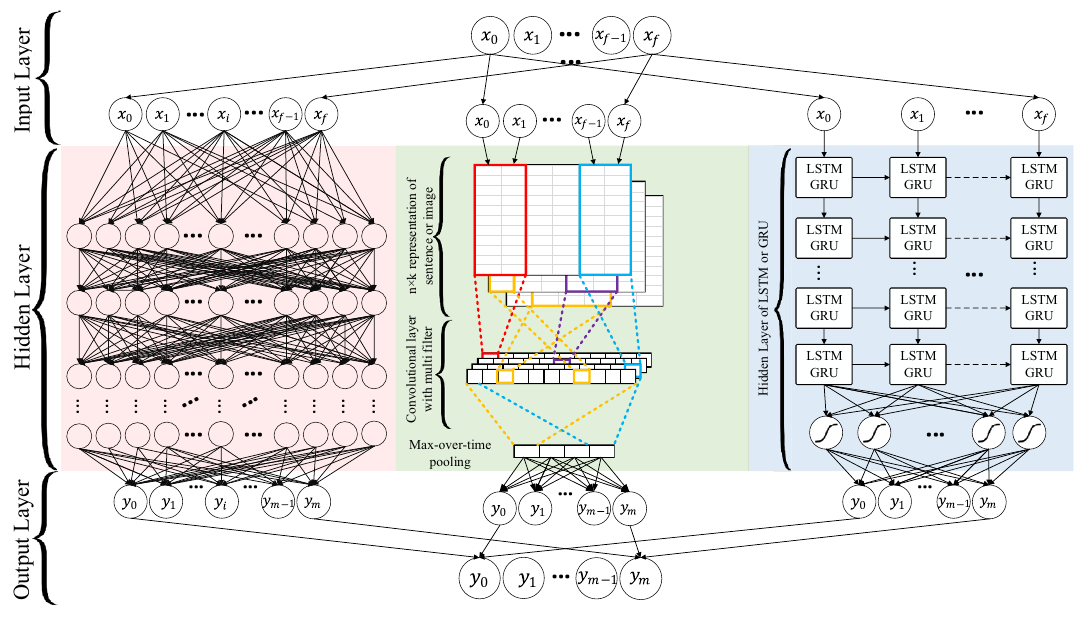
Figure 5. RDML architecture for